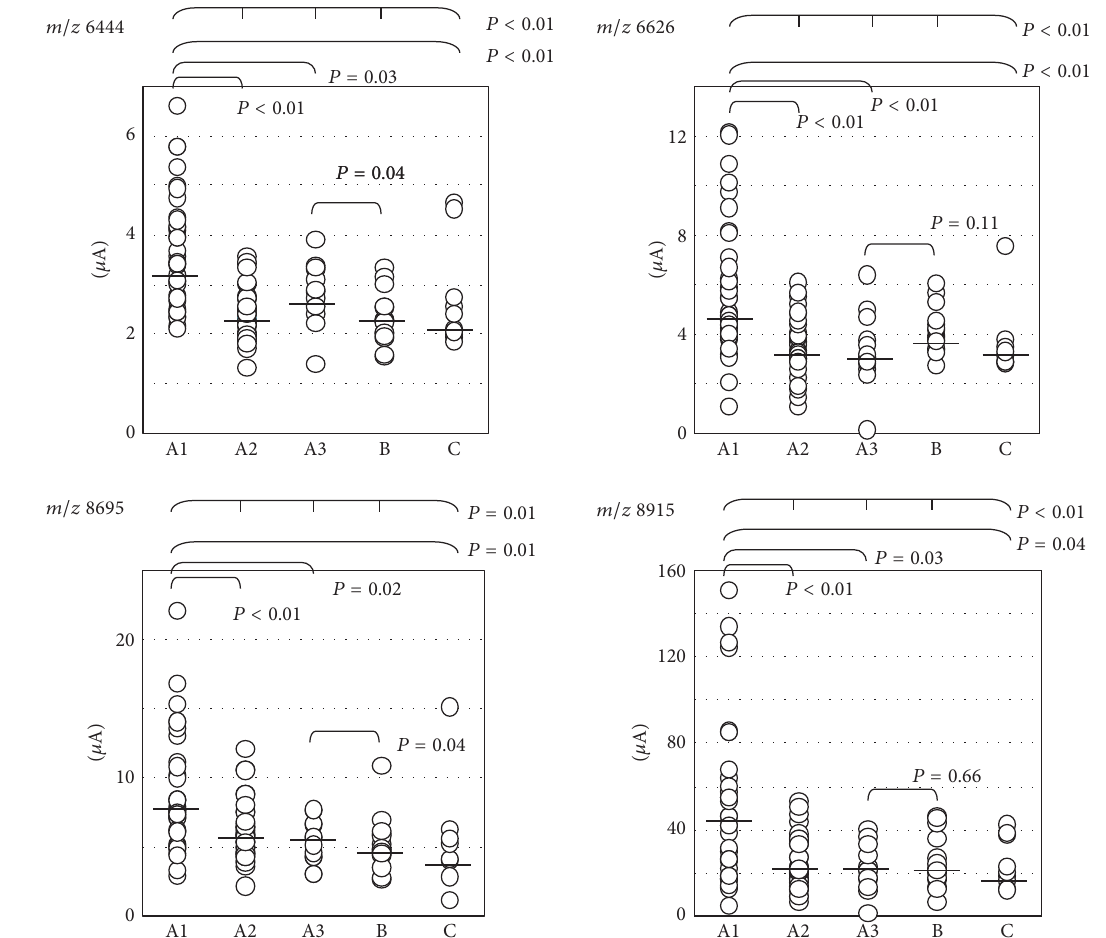
Figure 2: Intensity of each mass-to-charge ratio ( m/z ) level. Horizontal bars show each median value. The intensity of each m/z increased during Phase A1